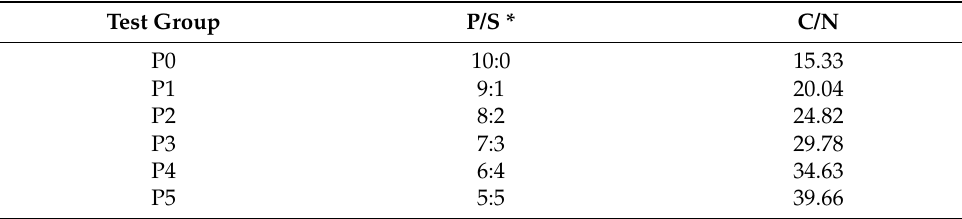
Table 2. Experimental designs.